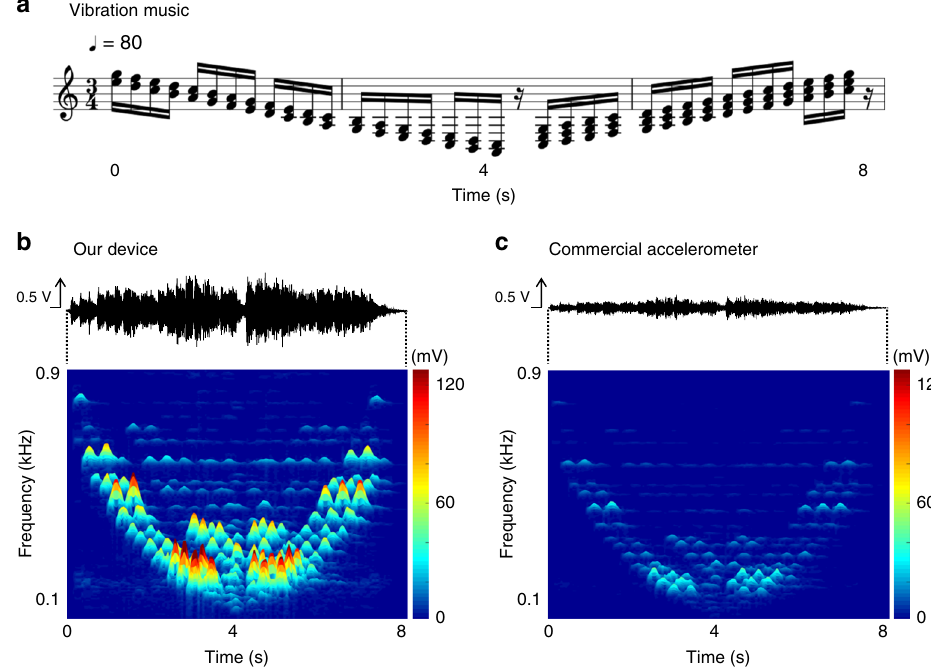
Fig. 3 Comparative vibration recognition test with commercial accelerometer. a While a sheet music was played by a vibration speaker (Newadin Technology, VBT-001), vibrational output was detected from our device and commercial accelerometer. b , c , Output waveform and its frequency spectrum from our device ( b ) and a commercial accelerometer (sensitivity: 100 mV g − 1 for 10~10,000 Hz) ( c ) as a function of